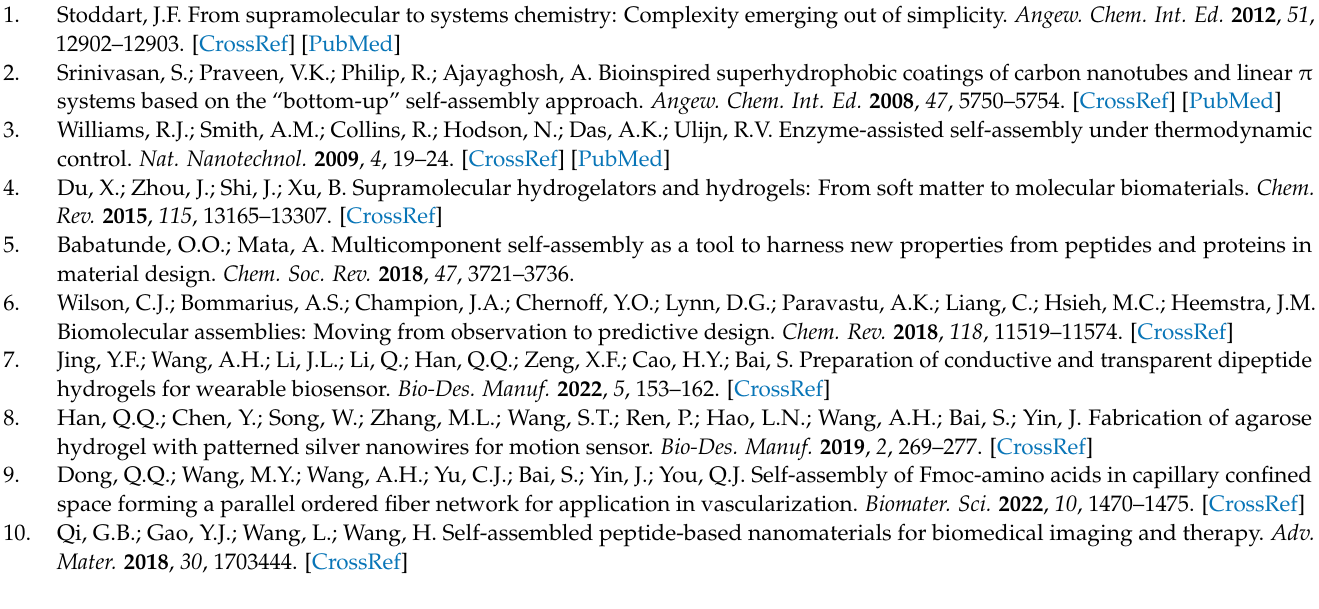
Figure S2: Shear thinning test of polyaniline doped conductive hydrogel; Figure S3: Swelling behavior of polyaniline doped conductive hydrogel; Figure S4: CCK-8 experiment with different Fmoc-w